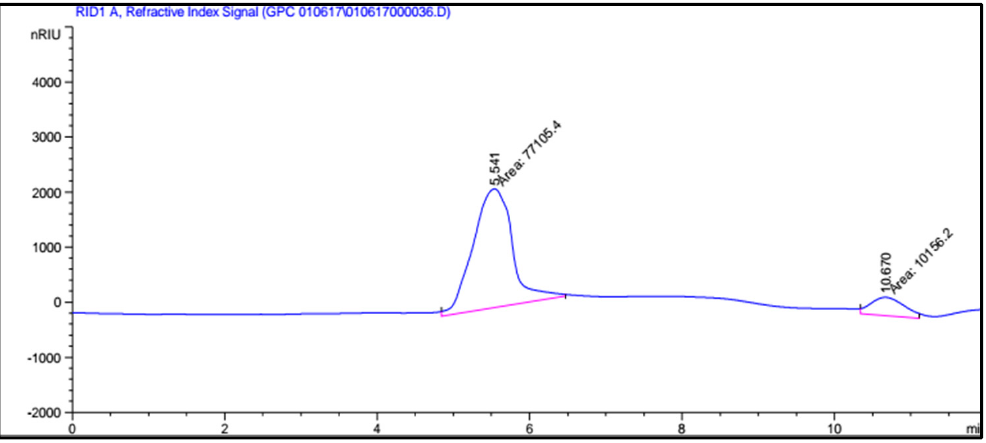
Figure 5. GPC spectroscopy of antioxidant carrageenan.